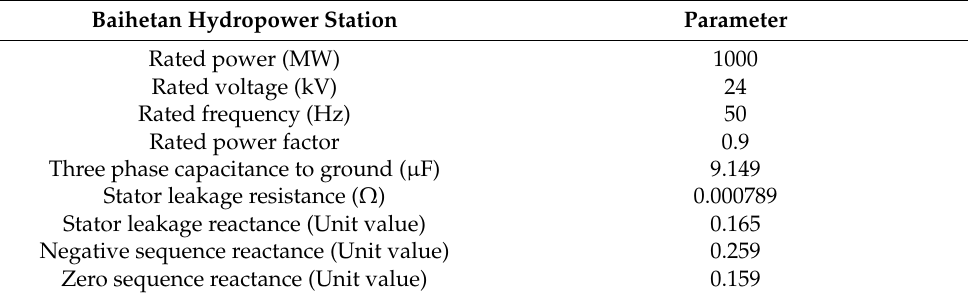
Table 1. Main parameters of 1000 MW hydro generator